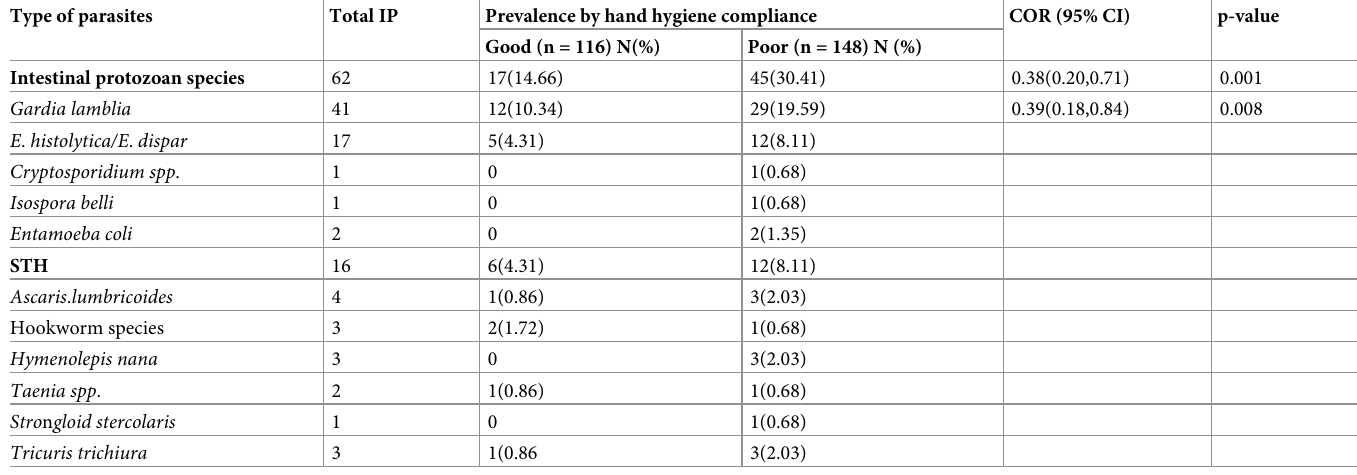
Table 2. Type and frequency of intestinal parasite species identified among patients attending Arba Minch general hospital outpatient department during COVID 19 pandemic, southern Ethiopia (from June to September